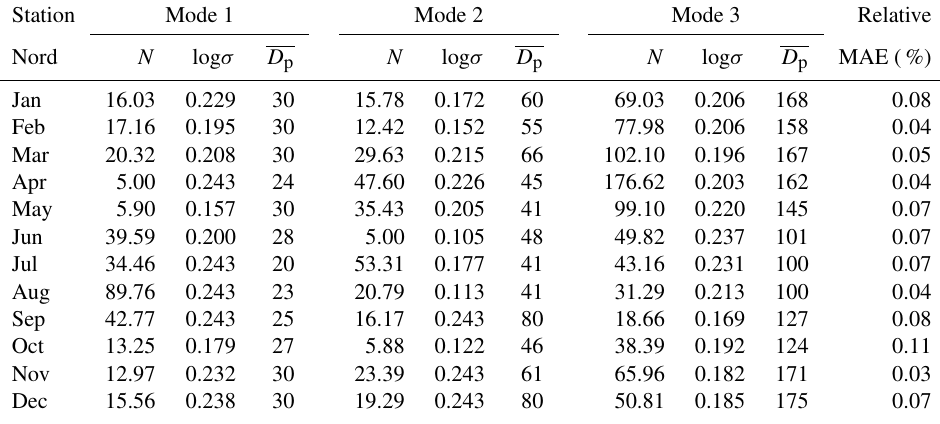
Table A3. Same as Table A1 but for Station Nord.